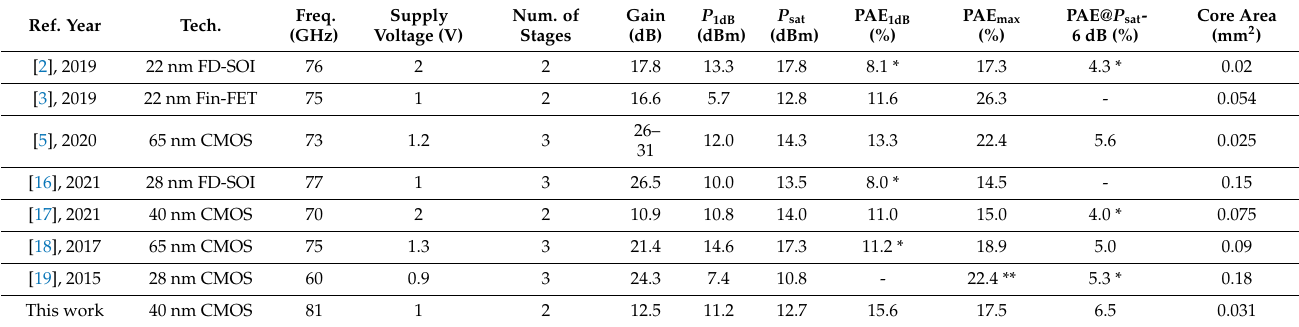
Table 1. E-band PA performance comparison.